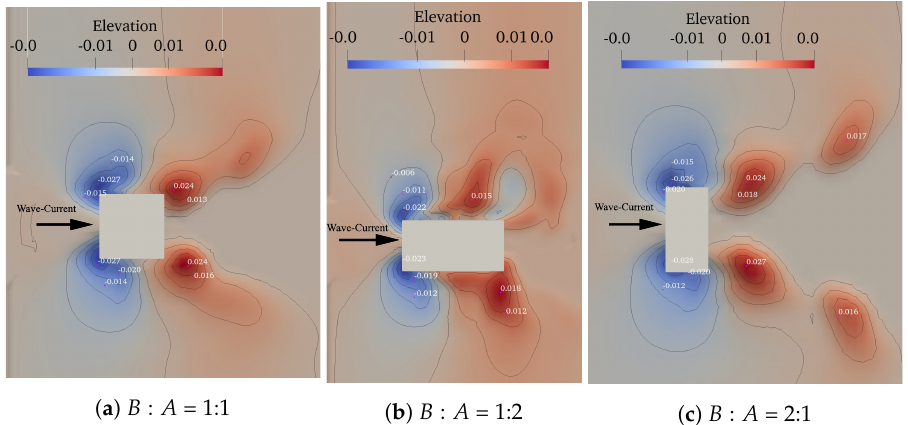
Figure 8. Contours at the end of the simulation period for combined wave − current ( U cw = 0.4) case for KC = 5.75 for varying aspect ratios of the rectangular pile. The side ( B ) of the rectangular pile is 0.14 m and the period (T) of the wave is 4.5 s. Duration of the simulation run is 3600 s.